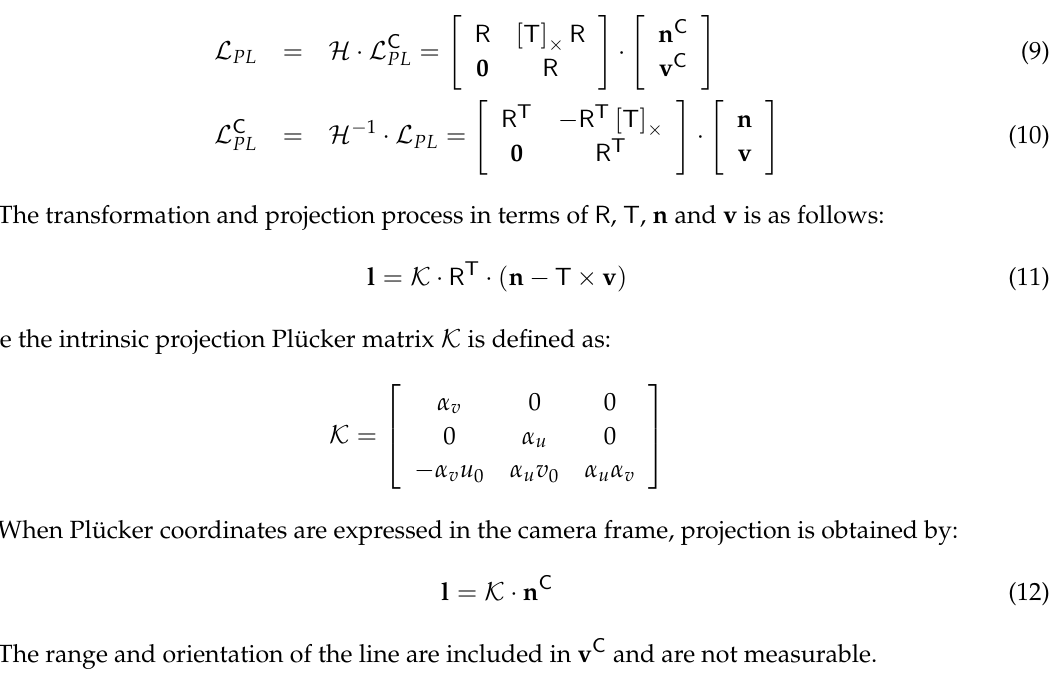
Figure 3. Line parametrizations used for initialization. ( a ) Plücker line geometrical representation; Figure 3: Pl¨ucker line back-projection. Image extracted ( b ) Plücker line back-projection; ( c ) anchored homogeneous-points line from [ ? ] Figure 4: Anchored homogeneous-points line parame- terization. Image extracted from [ ? ]